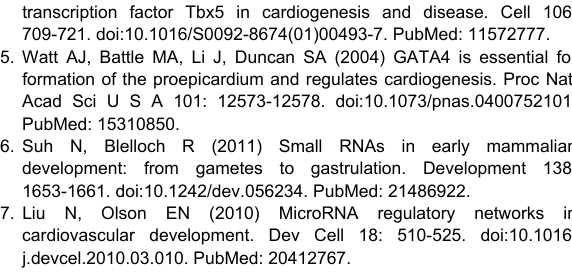
Figure S1. Bioinformatics analysis of RP11-473L15.2. ( A ) the transcription start site of FGF10. ( B ) As for Figure 5, a region of overlap between the various tracks in RP11-473L15.2 loci was also identified. ( C ) Prediction of TFBS indicated that RP11-473L15.2 combines with SRF. ( D ) However, no intense RNA-protein interaction between RP11-473L15.2 and TFs of FGF10 was